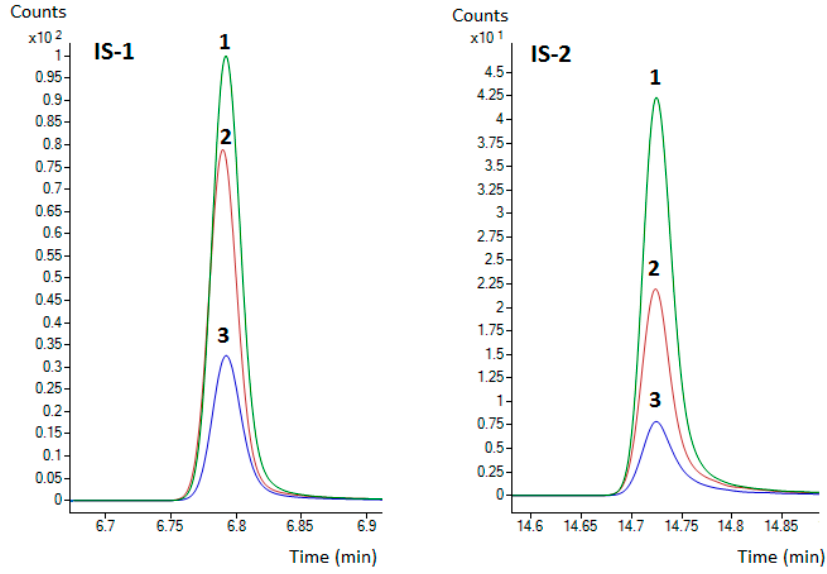
Figure 3. Dependence of the IS peak size on the lipid content of analyzed fish matrix. 1 — perch (3.0%), 2 — trout (8.2%), 3 — salmon (16%). Other parameters of these fish samples are presented in Table 7.